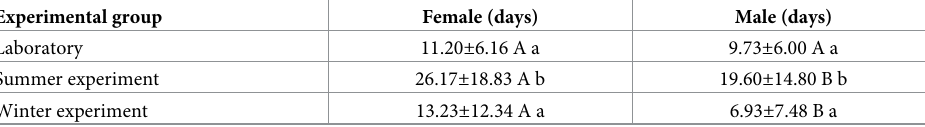
Table 3. Adult survival time of Ae . albopictus under different environmental conditions.